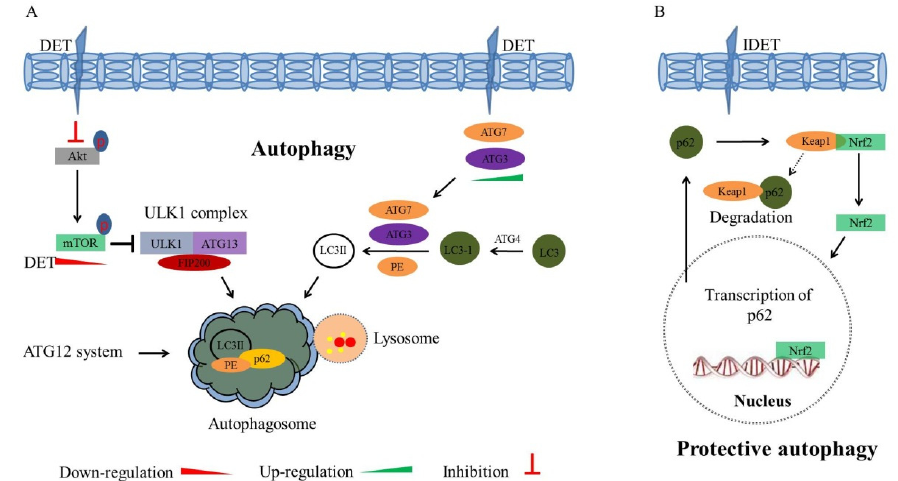
Figure 6. Schematic diagram illustrating DET-induced autophagy and IDET-induced protective au- tophagy. ( A ) DET-induced autophagy via the inhibition of PI3K/AKT/mTOR signaling. DET inhib- its the phosphorylation of AKT and mTOR, which results in ULK1 complex formation. DET up- regulates the expression of ATG3, ATG5, and ATG7, and induces the conversion of LC3I to LC3II conversion. The ULK1, LC3II, and ATG12 systems form autophagosomes. ( B ) IDET-induced pro- tective autophagy via Nrf2-p62-Keap1 feedback loop. Under normal physiological conditions, Nrf2 is transferred by keap1 to proteasome for degradation. Upon the induction of oxidative stress, Nrf2 is released from Nrf2-keap1 complex, and is translocated to the nucleus, where it activates the tran- scription of HO-1 and p62, which are downstream targets of Nrf2. Generally, p62 is downregulated during autophagy. IDET activates Nrf2 signaling and upregulates its downstream target p62. Up- regulated p62 binds competitively with Keap1, and Nrf2 is released from the Nrf2-Keap1 complex,